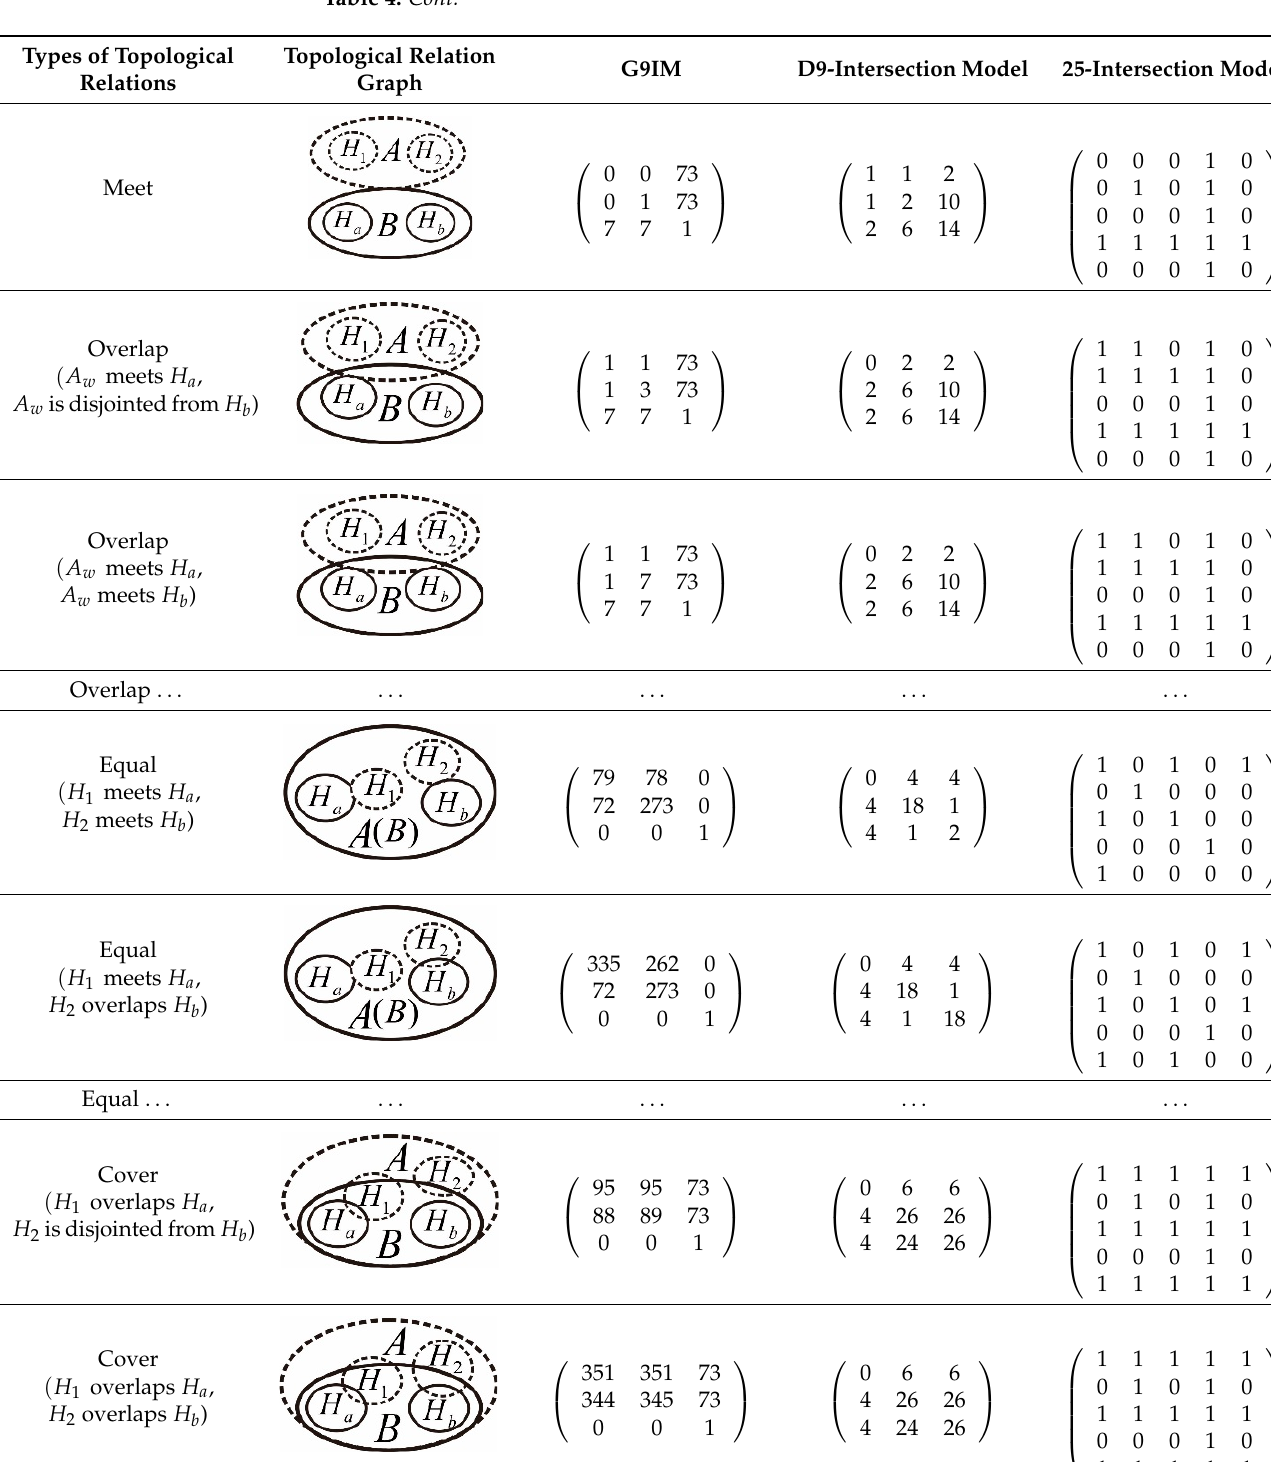
topological representation